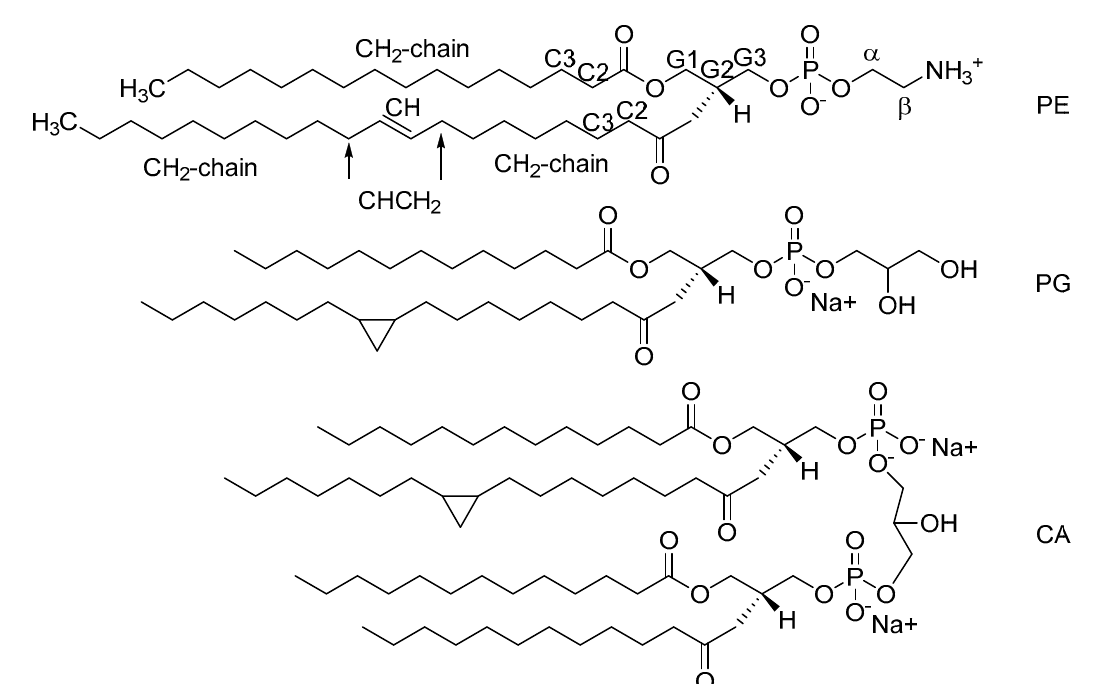
Figure 5. Example structures of the known components of the commercial E. coli lipid extract, L- α -phosphatidylethanolamine (PE), L- α -phosphatidylglycerol (PG), and cardiolipin (CA), with labeling on the PE lipid to illustrate the NMR assigned protons. The length and precise structure of the fatty acid chains (CH 2 ) have not been determined.